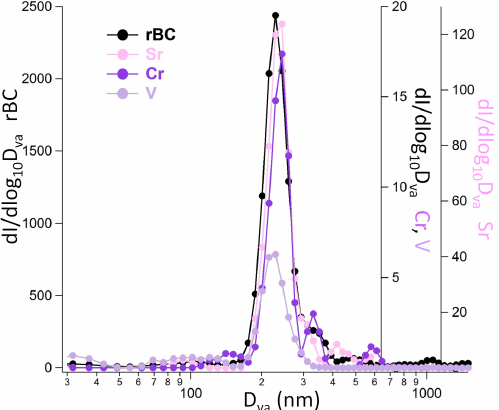
Figure 2. High-resolution signal intensity size distributions (HR- PToF) of rBC, V + , Cr + and Sr + .